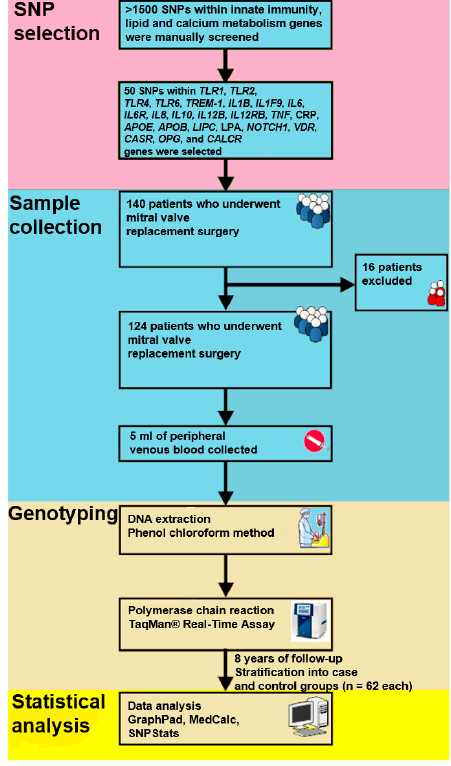
Figure 2. Study workflow. Figure 2. Study